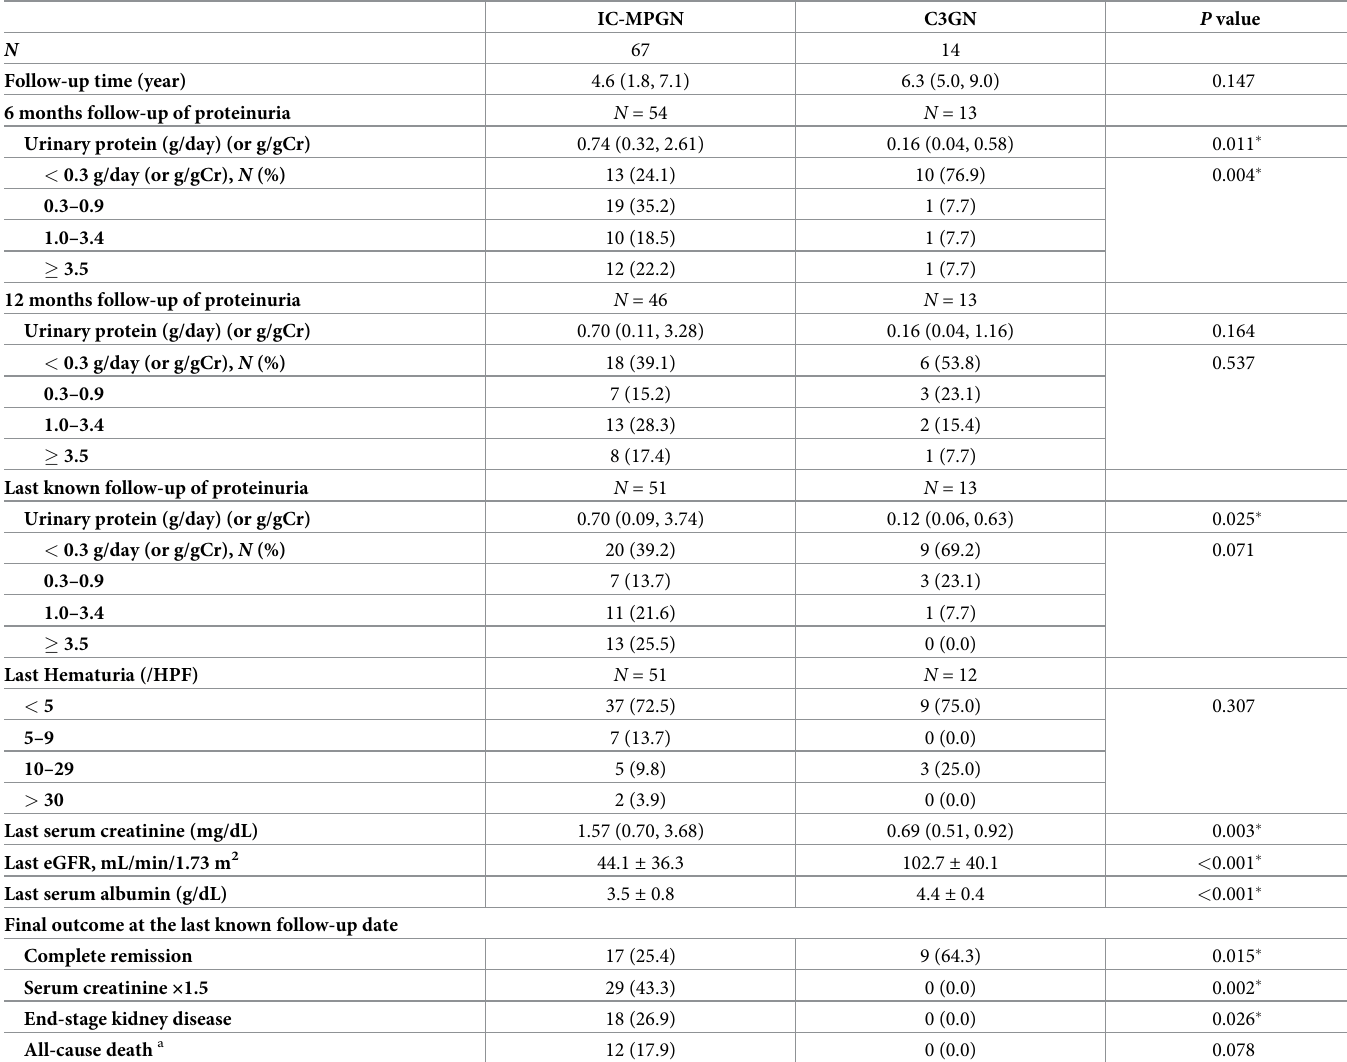
Table 2. Clinical findings and outcomes after treatment between IC-MPGN and